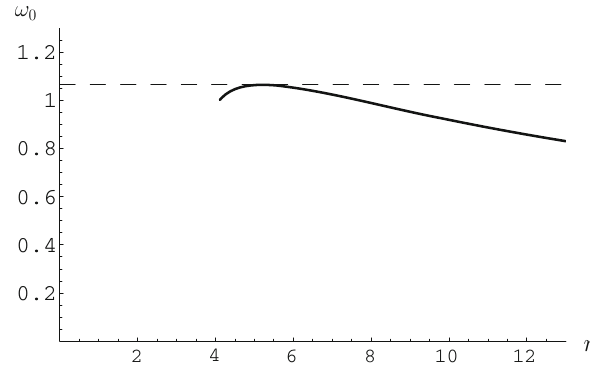
Fig. 1 Dependence of ω 0 (upper solid curve) and ω 1 (lower solid curve) on η . The dashed line shows the maximum value of ω 0 = 1 . 066 reached at η = 5 . 25, which corresponds to μ/(cid:14) = 13 .